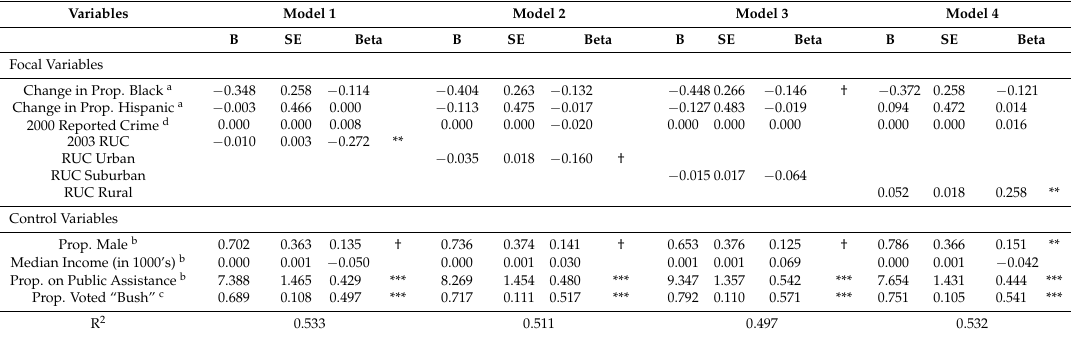
Table 2. Coefficients (SE) of Regressions Predicting Proportion of Votes in Favor of CCW